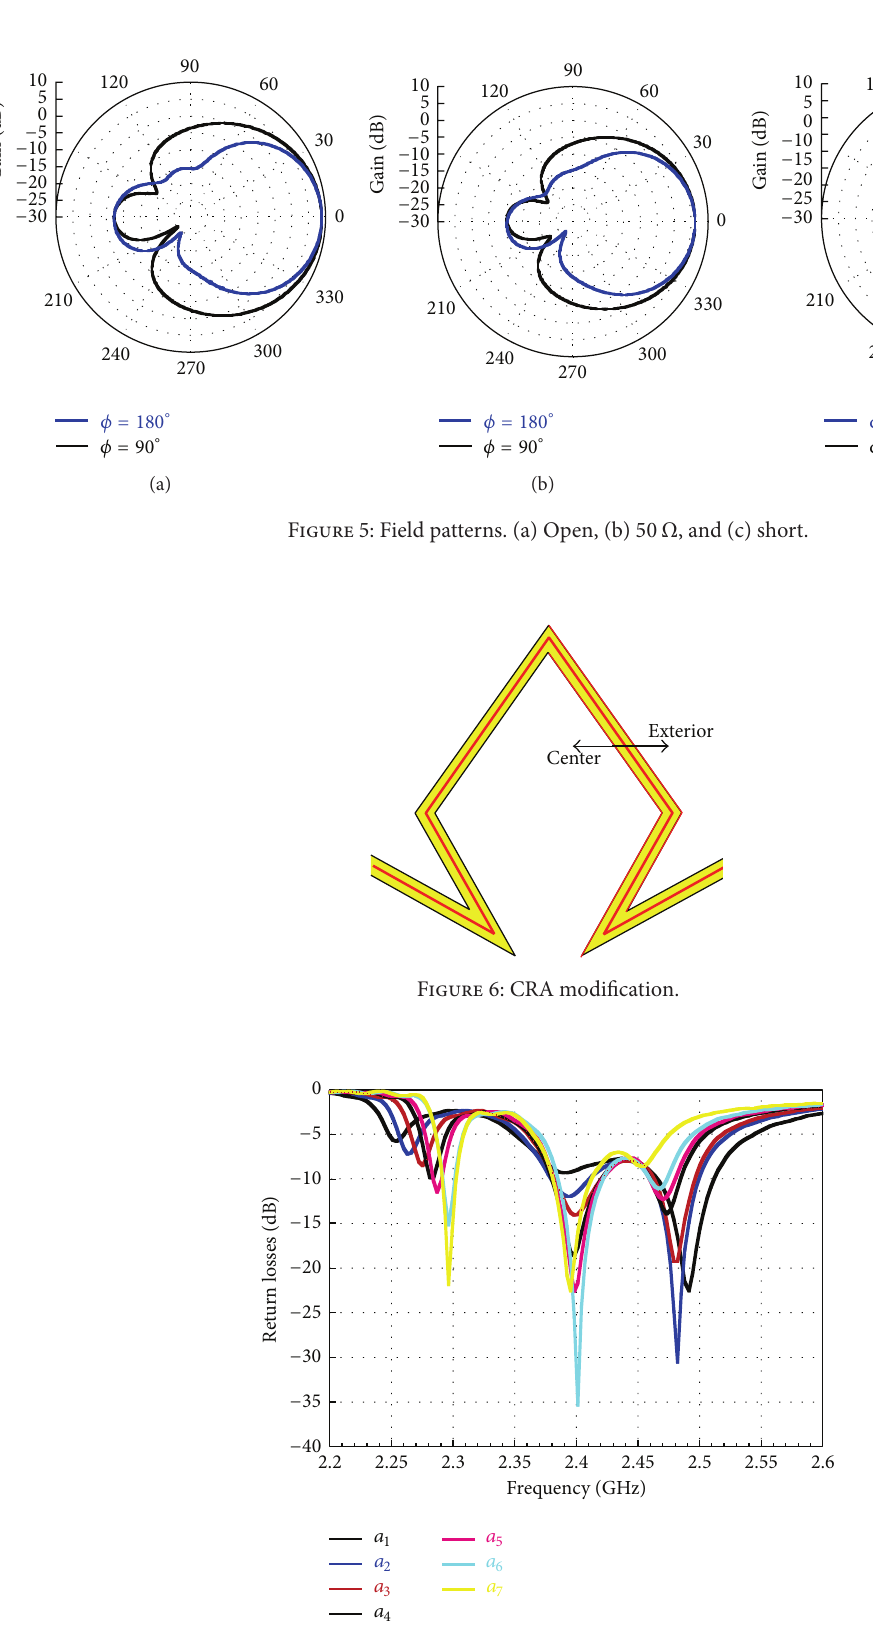
Figure 7: Return losses for different line